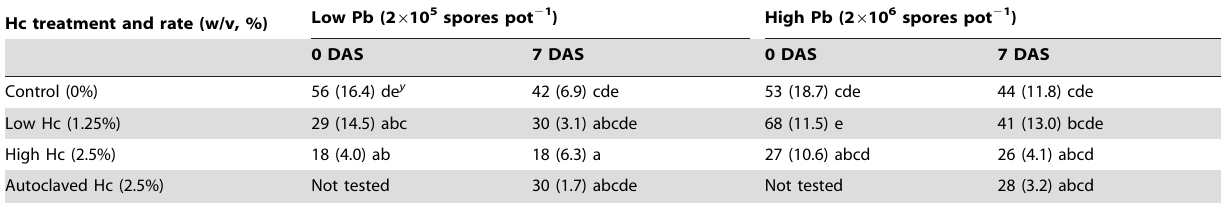
Table 1. Clubroot severity (disease severity index - DSI) on canola plants treated with a granular formulation of Heteroconium chaetospira strain B2HB1 (Hc) under high and low inoculum pressure of Plasmodiophora brassicae (Pb) added to the growth